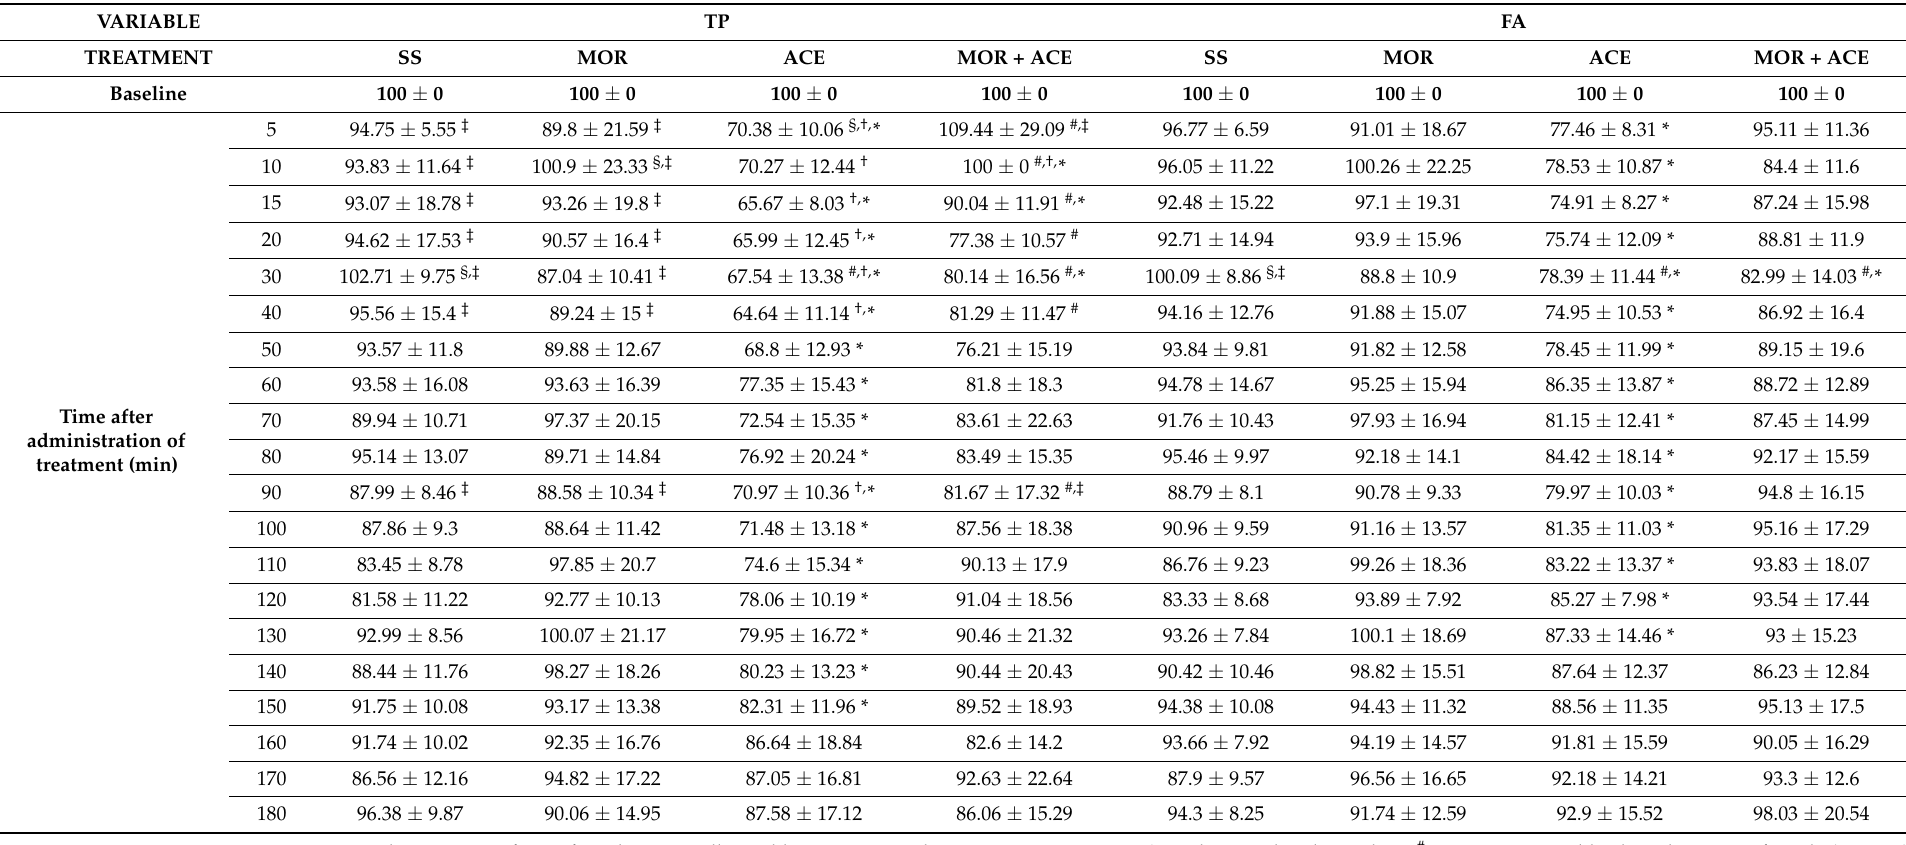
Table 4. Values at walk of energetic variables at − 10, 5, 10, 15, 20, and then every 10 min (total period of 3 h) after IV injection (at 0 min) of 10 mL of sodium